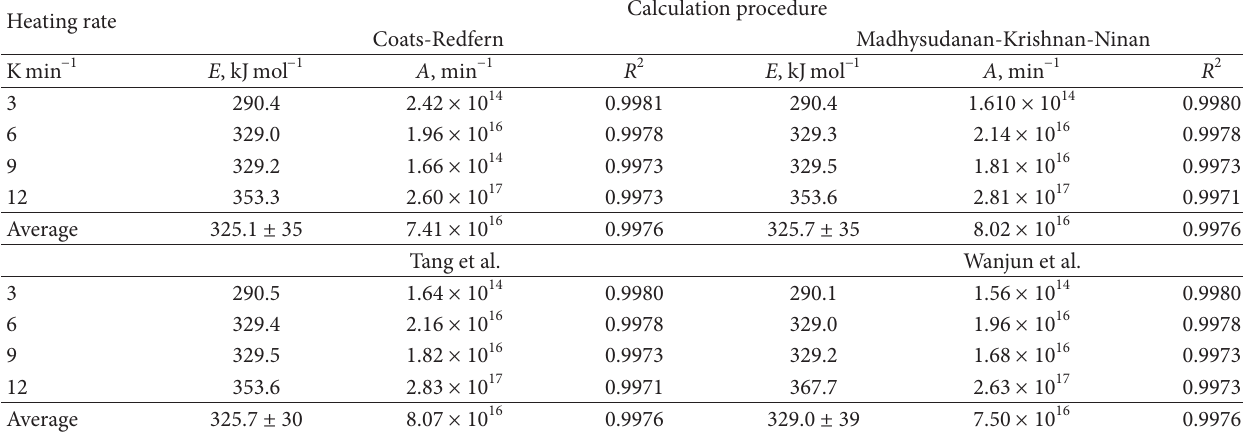
T 3: Effect of heating rate on kinetic data for the thermal decomposition of insitu produced CaCO